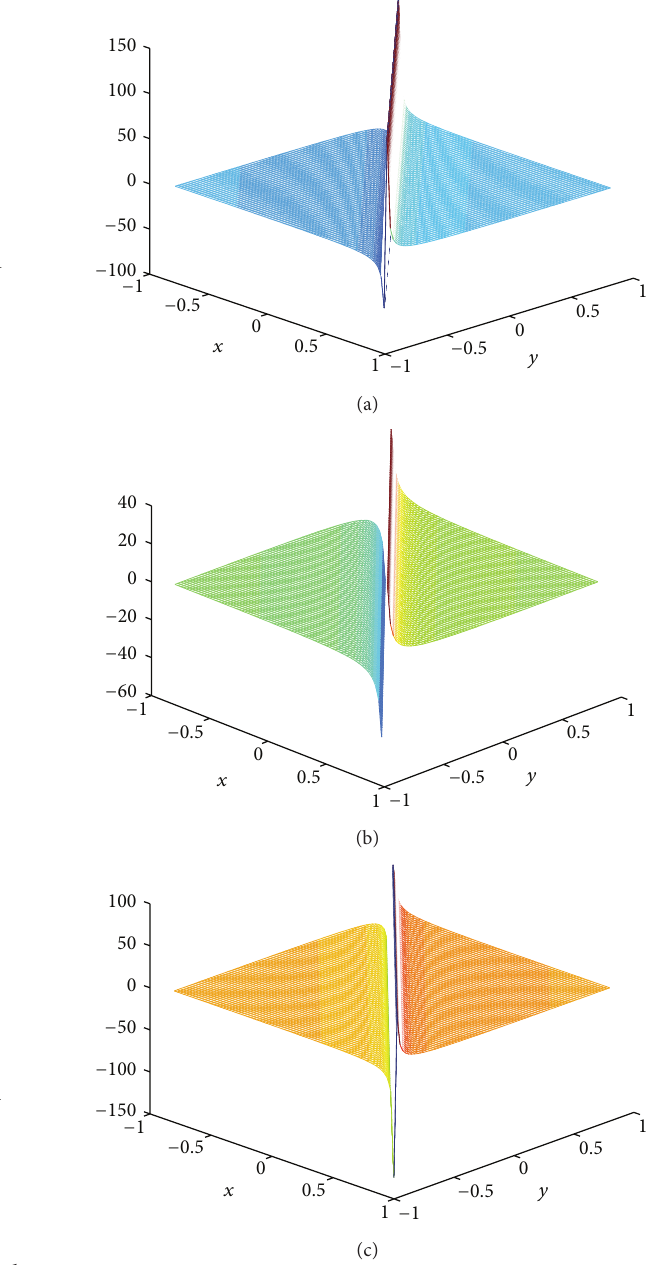
Figure 3: The solution of BLP corresponding to 𝑢 𝑠,3 : take 𝑐 = 1 , = 0 ; (a) 𝑡 = −1/132 , (b) 𝑡 = 0 , and (c) 𝑡 = 1/132 𝛼 = 1 , 𝑧 0